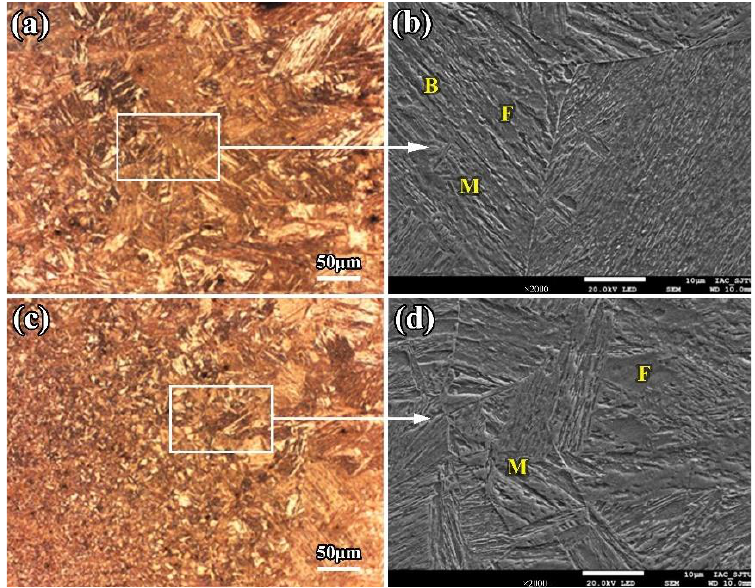
Figure 4. Microstructure of the CGHAZ of the LBW joint ( a ) CGHAZ close to fusion line ( b ) Martensite and bainite ( c ) CGHAZ far from fusion line ( d ) Martensite and ferrite. F: ferrite; M: martensite; B: bainite.